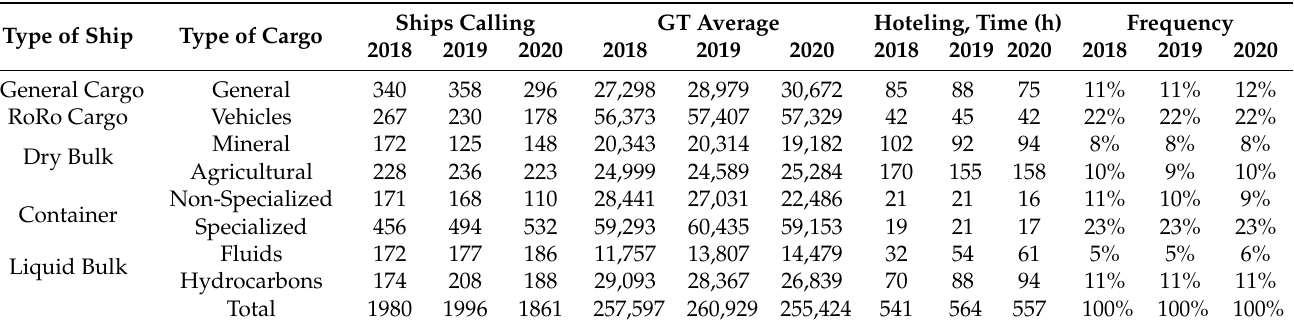
Table 1. Typology of ships in the Veracruz port system.